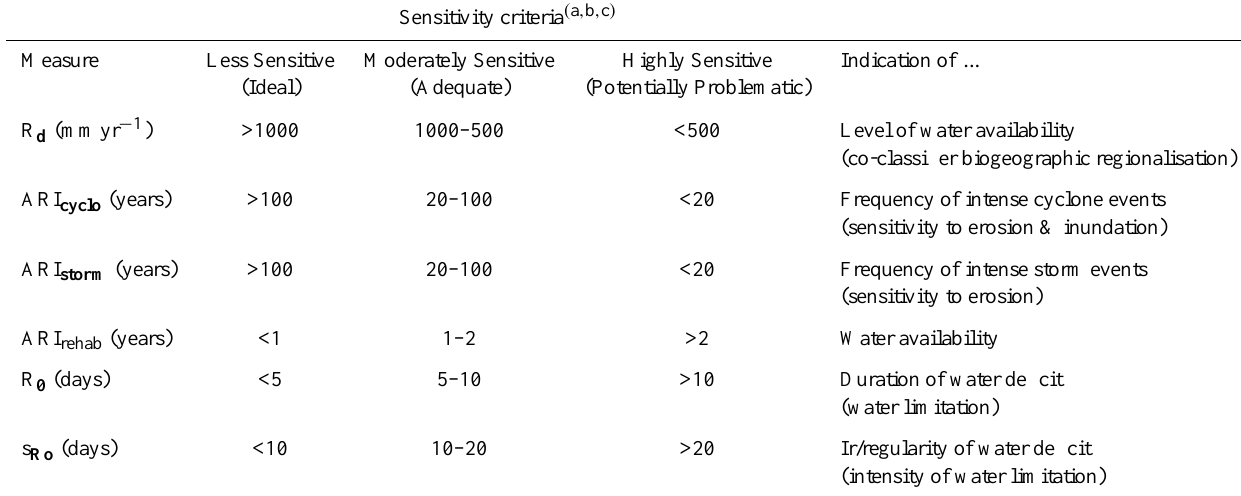
Table 2. Rainfall parameters for climate sensitivity criteria and their biological or morphologic